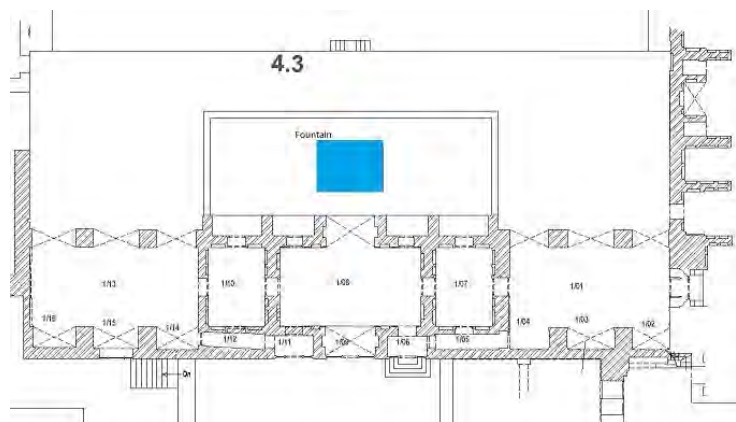
Figure 6. Plan of Khawab gah e Shah Jahani